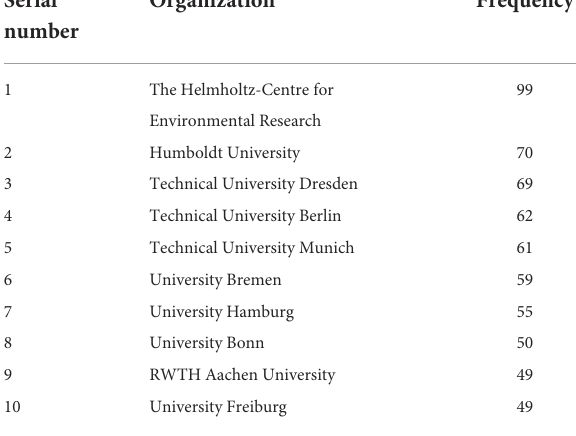
TABLE 2 Top ten universities and research institutes engaged in environmental research in Germany with the highest